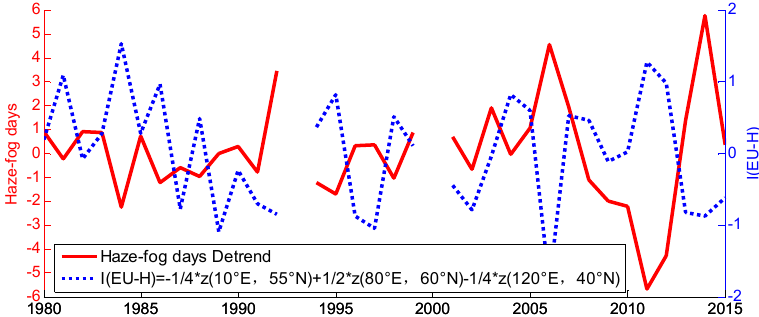
Figure 5. The detrended number of haze-fog days (red, units: days) and the EU index (blue) in January from 1980 to 2012.